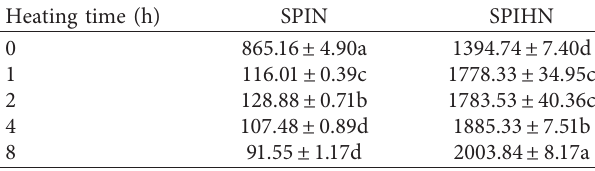
Figure 6: ThT spectroscopic profiles of SPIN and SPIHN. Table 2: The surface hydrophobicity of SPIN and